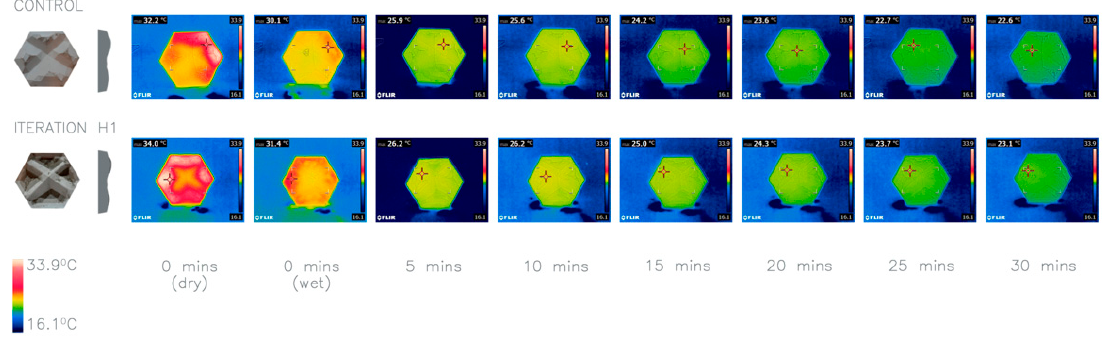
Figure 10. Thermal imaging of investigation 7: comparison between two iterations H1 compared to a control panel. Average heat loss after 30 min: Control 9.1 °C, H1 10.2 °C.